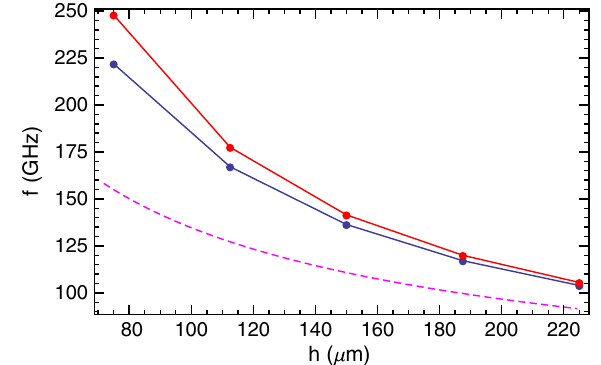
FIG. 6. Frequency of the resonant modes for five different values of h indicated by dots. The red color shows the theoretical values; the blue color is simulations with KN7C . Also shown, for comparison, is the result of a normally used model: our model with (cid:2) ¼ g=p but with (cid:1) (cid:1) 1 set to zero (dashed, magenta curve).